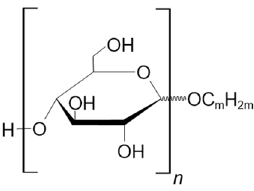
Figure 3. The general structure of alkylpolyglycosides. The index n denotes the number of glucose monomers and varies from 3 to 10. The index m denotes number of carbons in alkyl chain and usually varies from 4 to 18 [42,43].